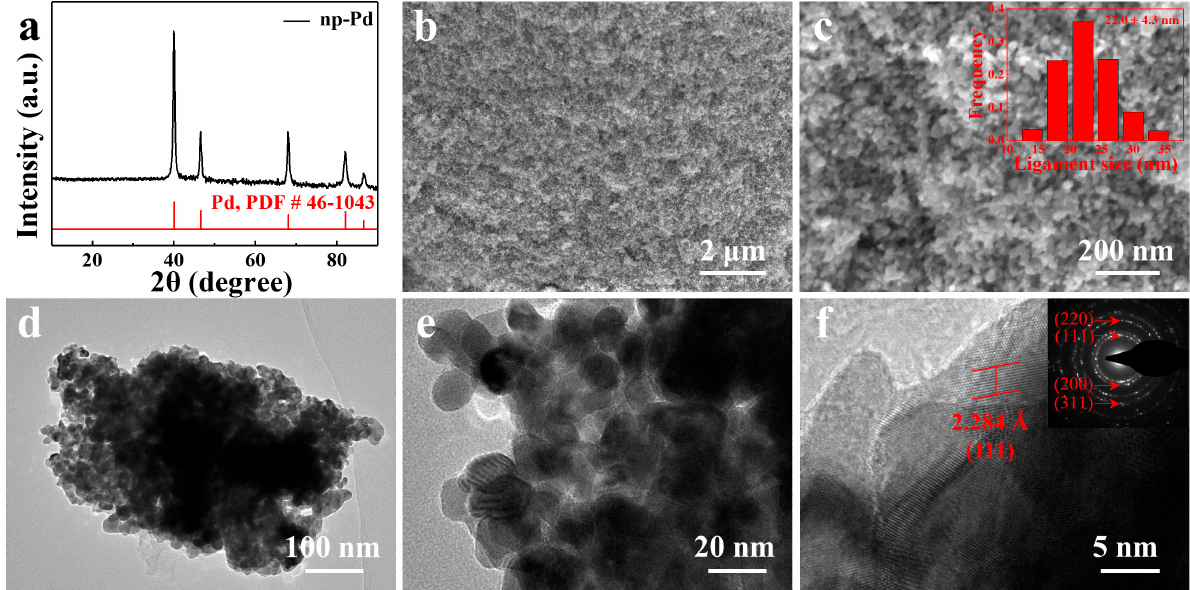
Figure 9. ( a ) XRD pattern, ( b , c ) SEM images, ( d , e ) TEM images, ( f ) HRTEM image and SAED pattern (inset) of the np-Pd. The ligament size distribution of the np-Pd is displayed in ( c ) as an inset. Next, we investigated the electrochemical actuation behavior of the bulk np-Pd. The cyclic voltammetry (CV) technique was first employed. A series of periodically varying electrode potentials at different scan rates were applied to induce strains. Figure 10a records time curves for high scan rates (from 50 to 10 mV s − 1 ) are magnified as an inset. Figure 10b shows the CV curve of the np-Pd at the scan rate of 1 mV s − 1 . The forward potential scan from − 1.4 to 1 V vs. SCE sequentially triggers the hydrogen adsorption/absorption (HA) (accompanied by hydrogen evolution [43]), hydrogen desorption (HD), OH adsorption (OA) and the formation of Pd oxides [16,44,45]. During the back scan, both the reduction of Pd oxides and OH desorption (OD) are